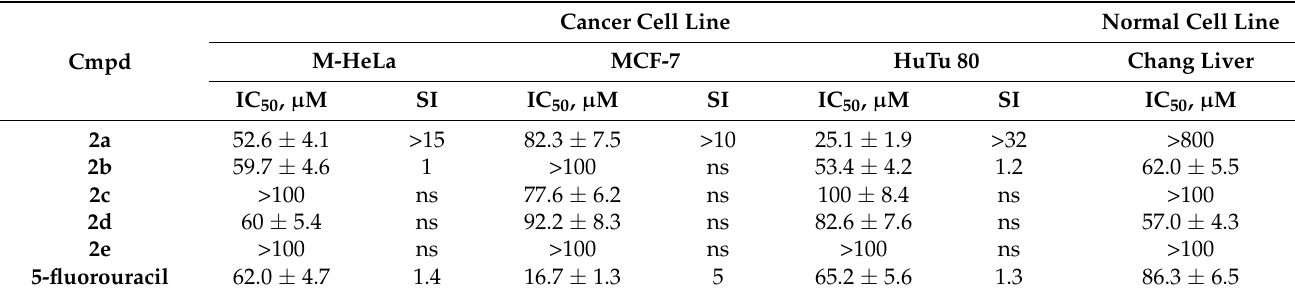
Table 1. Cytotoxic effects of phosphacoumarins 2 on the cancer and normal human cell lines 1 . Cancer Cell Line Normal Cell Line M-HeLa MCF-7 HuTu 80 Chang Cmpd